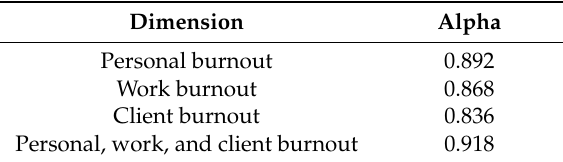
Table 2. Results of the Cronbach’s Alpha for the questionnaire